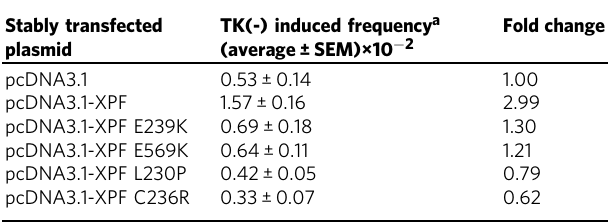
TK(-) induced frequency